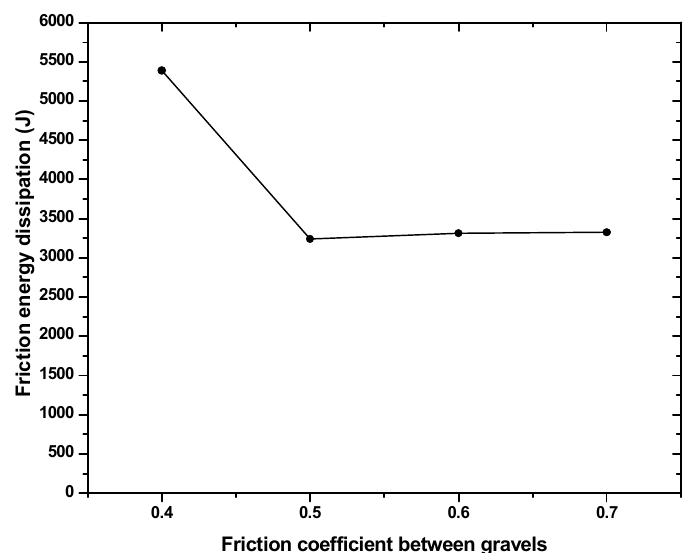
Figure 15. Comparison of friction-energy dissipation for different friction coefficients between the gravel and the weight.